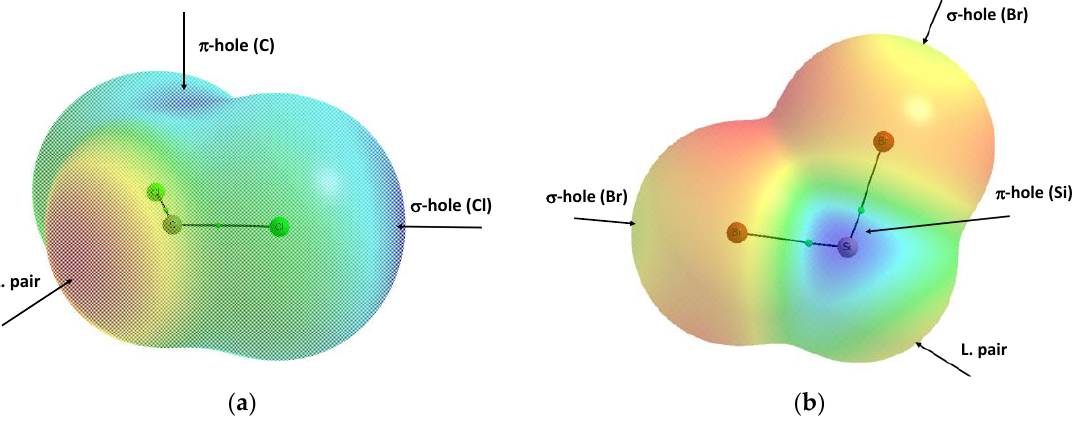
Figure 4. The molecular graphs of ( a ) CCl 2 and ( b ) SiBr 2 . The surfaces of the electron density of 0.001 au are presented with the maps of the electrostatic potential (EP), the blue color corresponds to the positive EP value while the red color corresponds to the negative EP value.